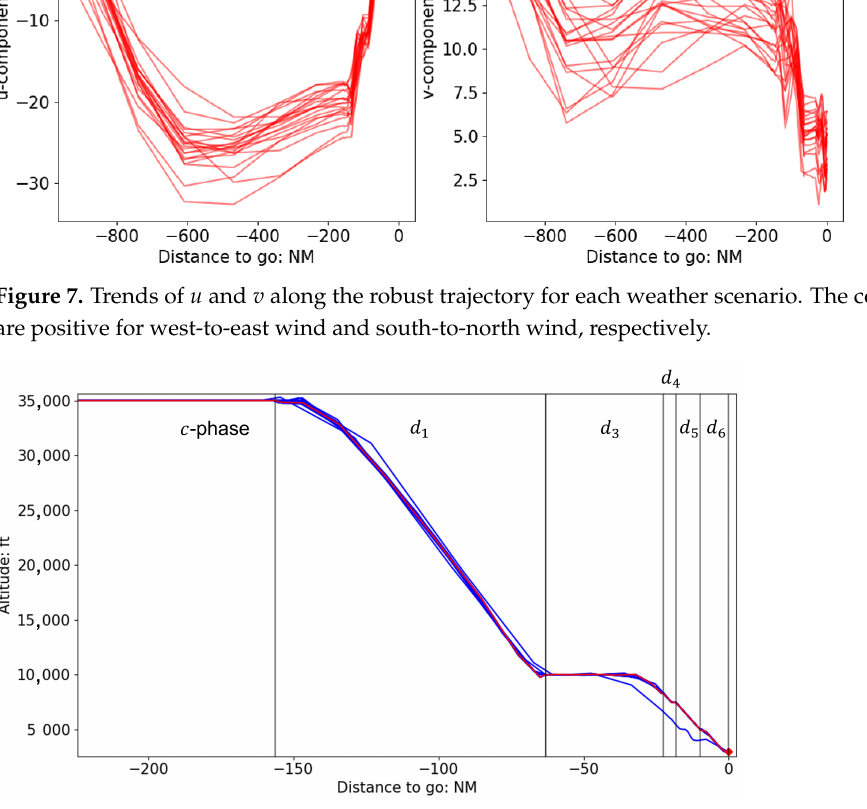
Figure 8. Vertical paths of the robust (red) and the scenario-optimal (blue) trajectories (with C I = 30 kg/min, RTA not imposed). The trajectories cover the last part of c -phase and the following descent phases. The vertical lines corresponds to phase edges of the robust